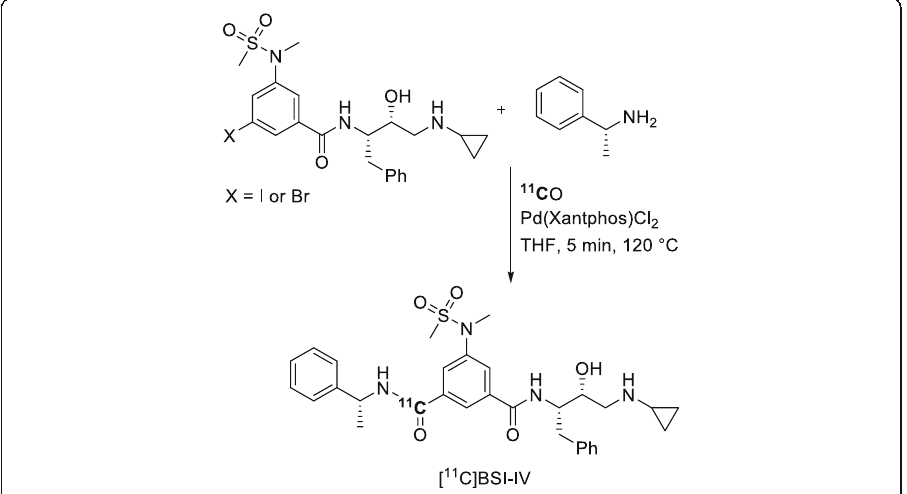
Fig. 25 Synthesis of [ 11 C]BSI-IV through a Pd-mediated 11 C-aminocarbonylation